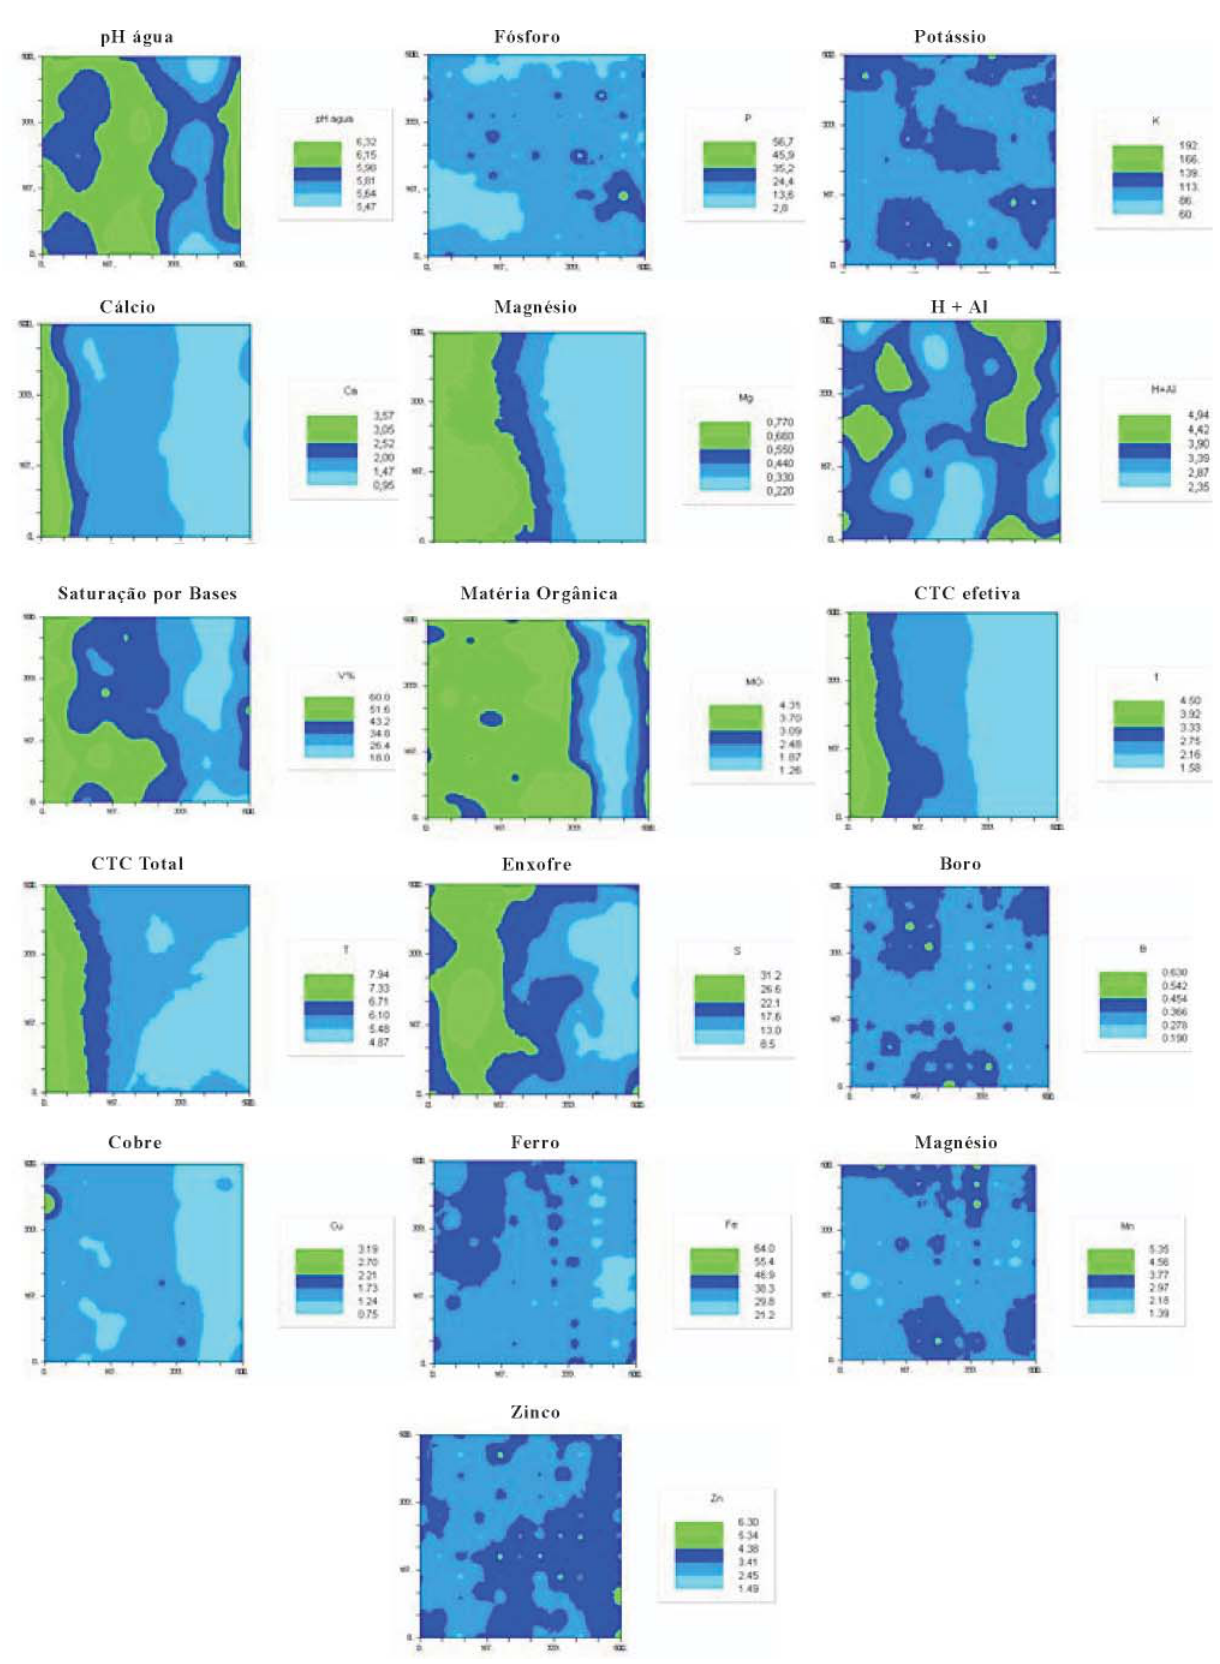
Figura 3. Mapas de variabilidade espacial dos atributos químicos estudados, na profundidade de 0-20